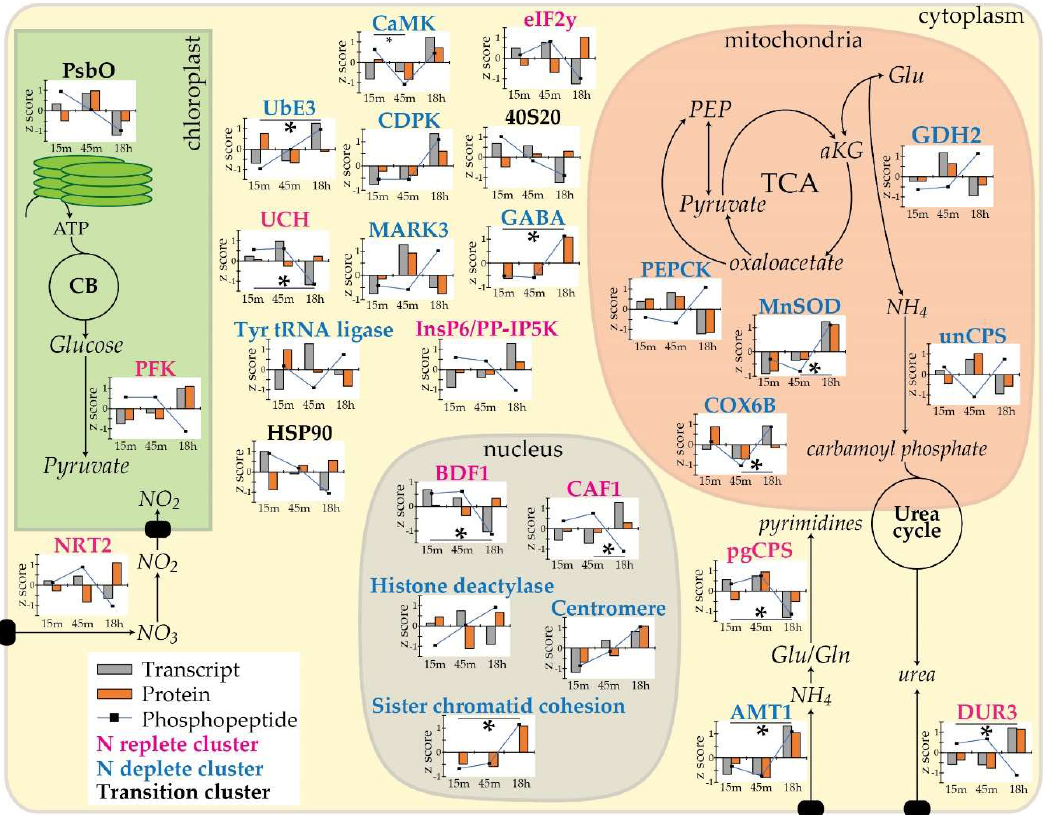
Figure 4. Phosphoproteins which are impacted by cellular nitrogen status. Transcripts (grey) [18], protein (orange) and phosphoprotein (blue line) levels are depicted. Phosphoproteins were classified into N replete (pink), N deplete (blue), or N transition (black) clusters by hierarchical clustering. Significant fold change (log2 FC > 1) in phosphopeptide abundance between timepoints are indicated by an asterisk on the graphs. Phosphofructokinase (PFK; Phatr3_EG02209), nitrate/nitrite transporter